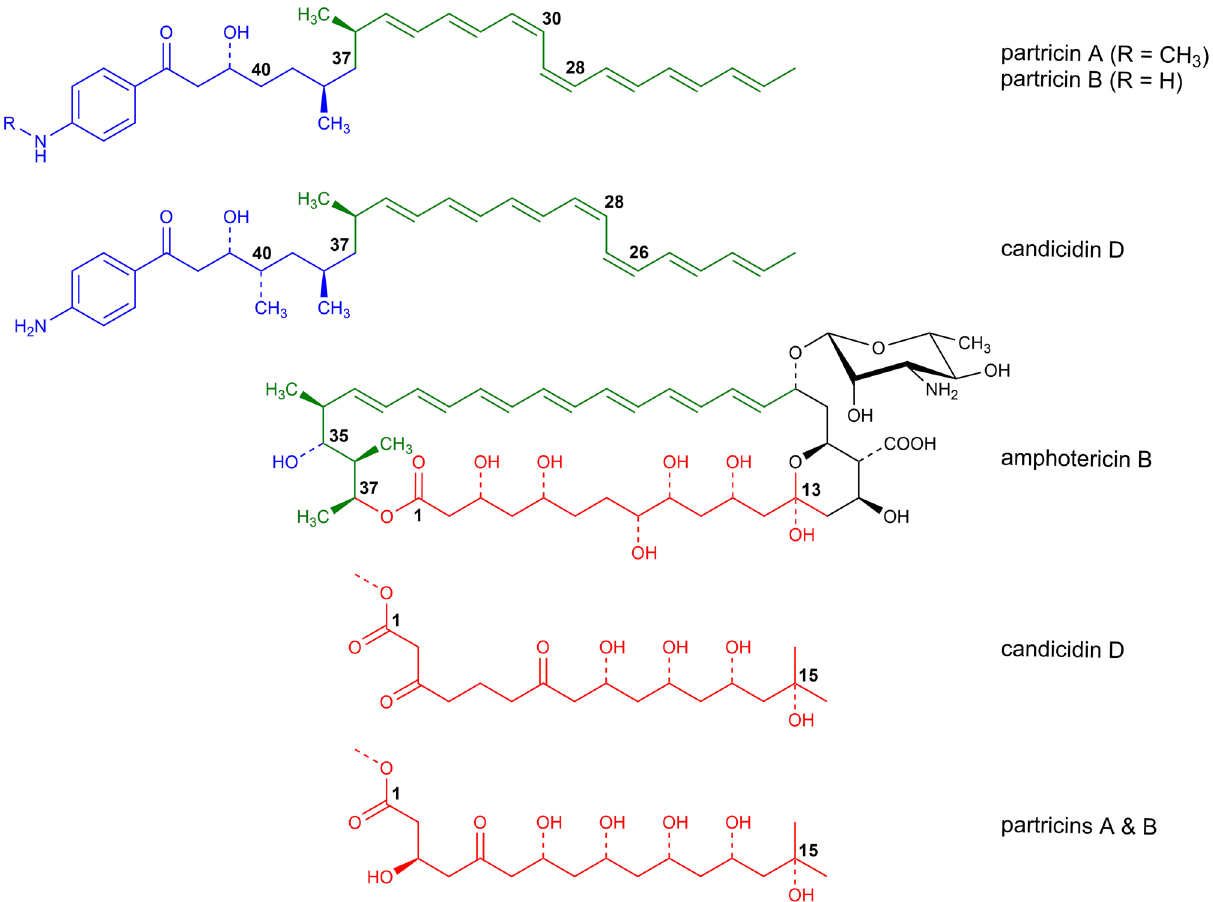
Figure 14. Structural differences between the native AHMs and AmB. Colours: red—polyol region; green— chromophore; blue—alkyl-aromatic